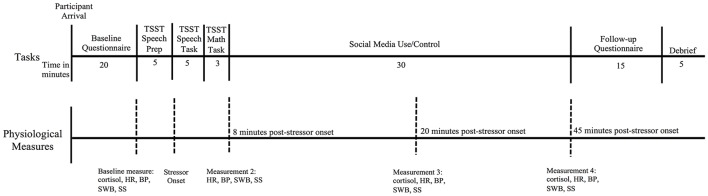
Timeline for procedural tasks and physiological sample measurements. TSST, Trier Social Stress Test; HR, heart rate; BP, blood pressure; SWB, subjective well-being; SS, subjective stress.